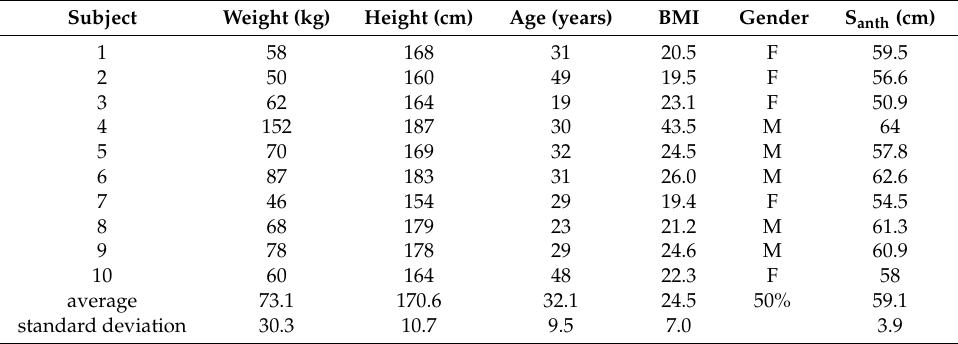
Table 1. Mean and standard deviation for personal data and parameters of the 10 subjects. S anth = mean anthropometric step